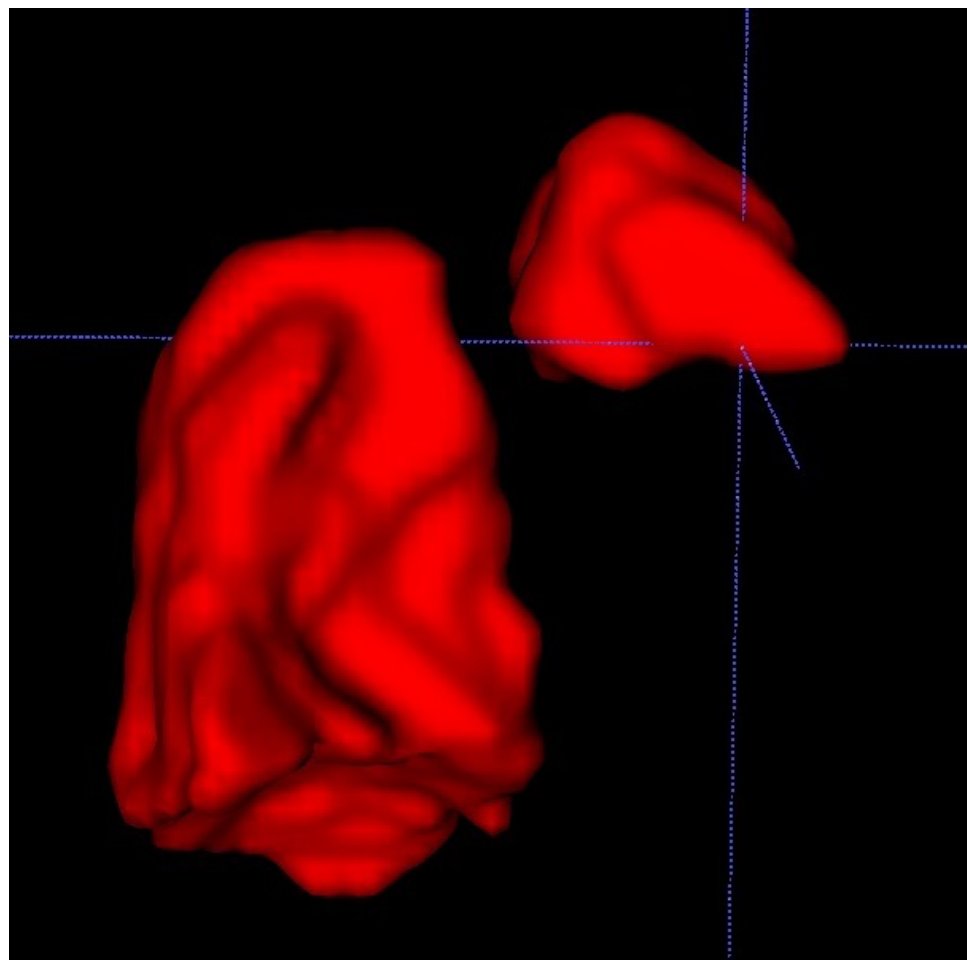
Figure 3. Showing a 3D rendition of the fetal lungs in Figures 1 and 2 using the ITK-SNAP